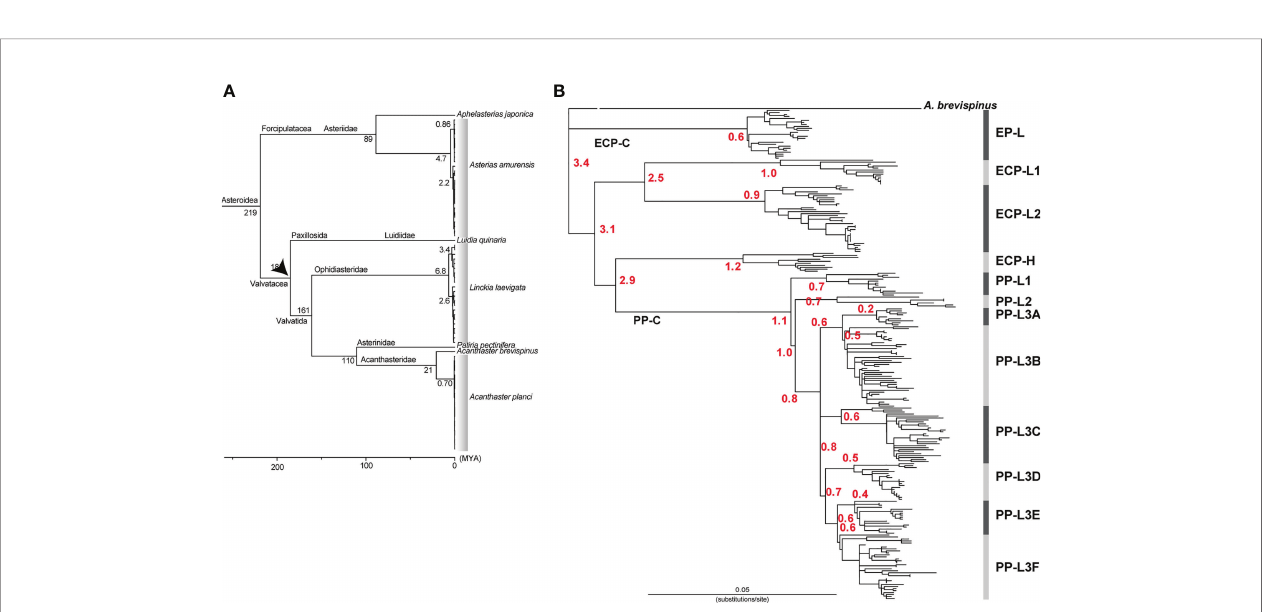
FIGURE 5 | Estimated divergence times (A) between different species of star fi sh based on Inoue et al. (2020) and (B) those between different lineages of COTS (shown by red numerals). The estimation was based on the RelTime method using 21 MYA as the diversi fi cation time between of Acanthaster brevispinus and A. cf. solaris.